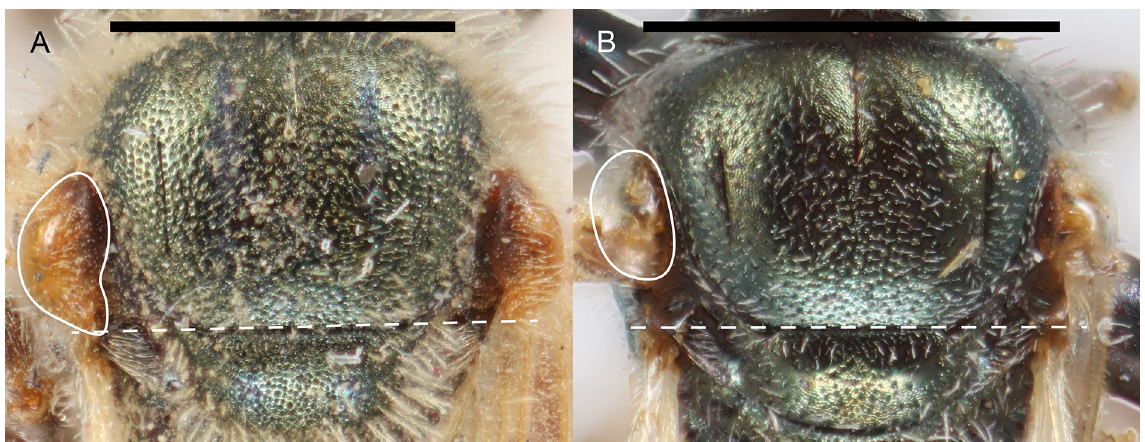
Fig. 91. Tegula. A . Lasioglossum ( D. ) hunteri (Crawford, 1932), ♀, enlarged, reaching scutellum, with concave inner posterior margin. B . L. ( D. ) clematisellum (Cockerell, 1904), ♀, ovoid and not reaching scutellum. Scale bars: 1 mm.